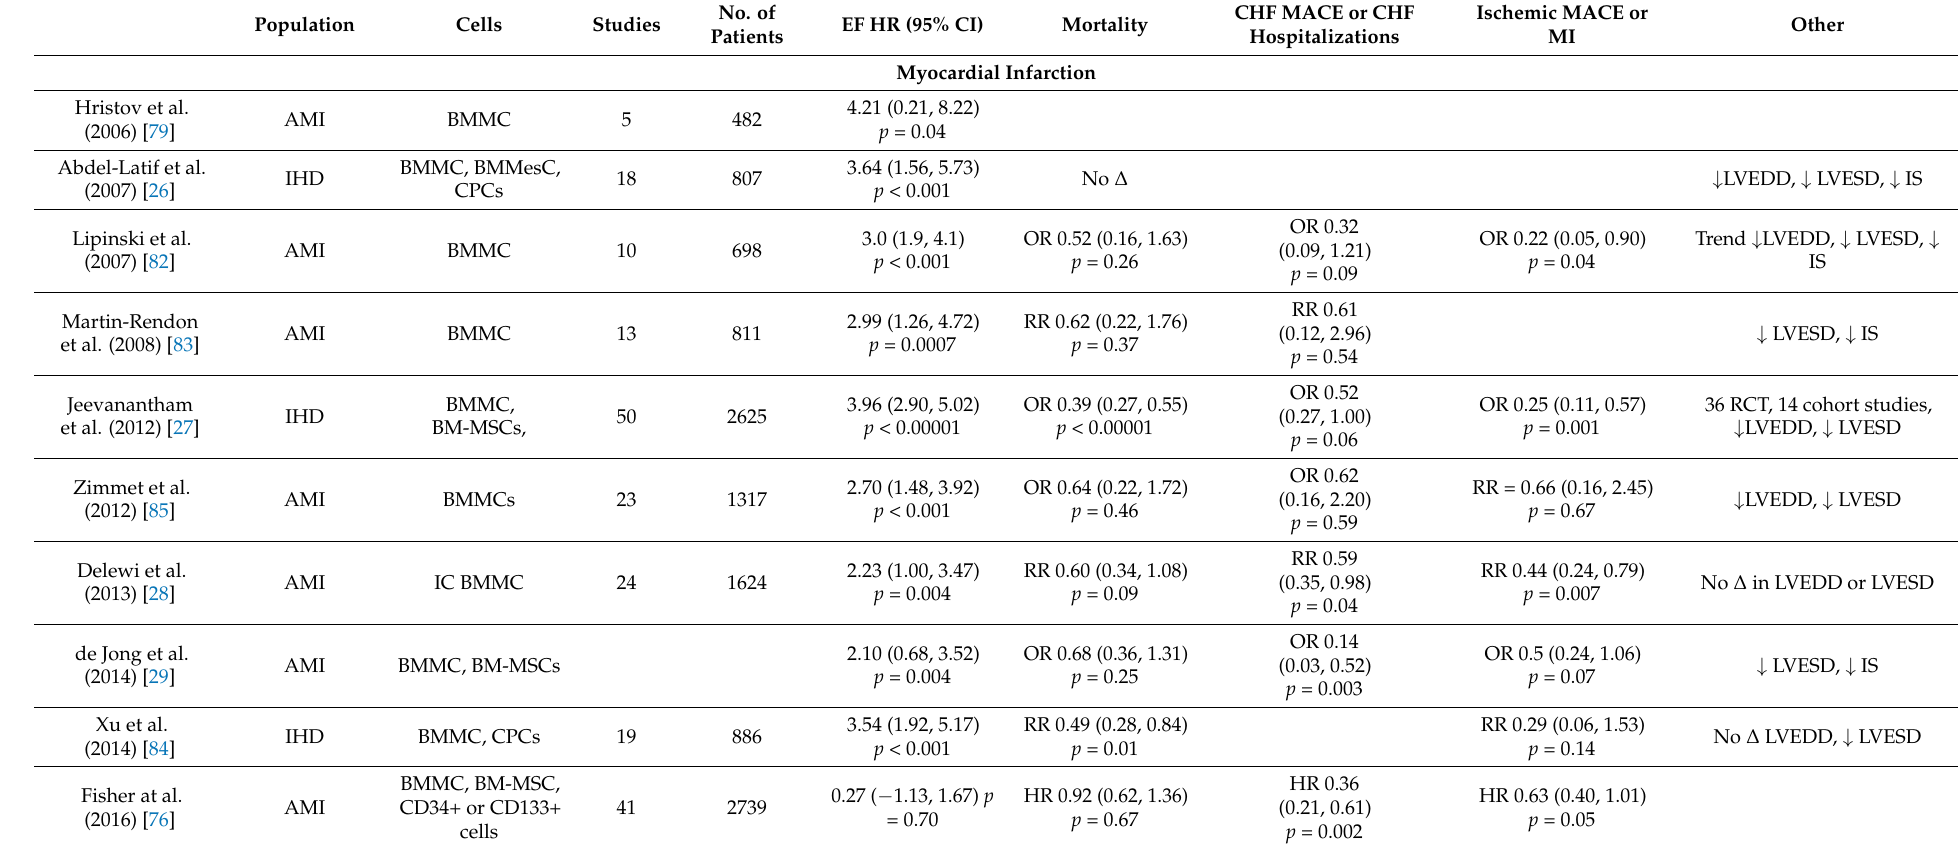
Table 2. Summary of meta-analyses of Bone Marrow Cell Therapy for Ischemic Heart